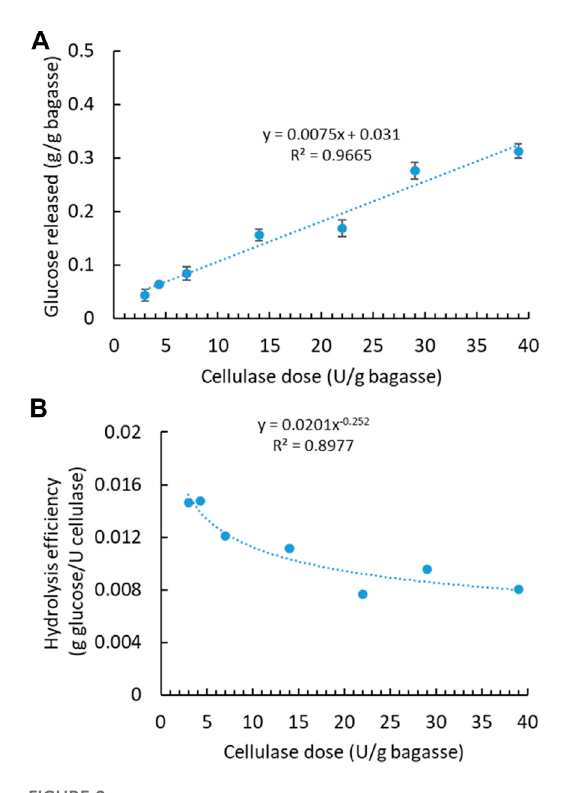
FIGURE 2 Enzymatichydrolysisofsolublesugar-free SCB withcellulase enzyme. (A) Effect of cellulase dosage on glucose concentration. (B) Hydrolysis ef fi ciency versus cellulase dosage. (Reaction condition: 0.1 g of SCB, varying cellulase dosages, 400 μ g tetracyclineand300 μ gcycloheximide,pH4.8,temperature 50 ° C, and time 24 h. Final volume: 10 ml in each